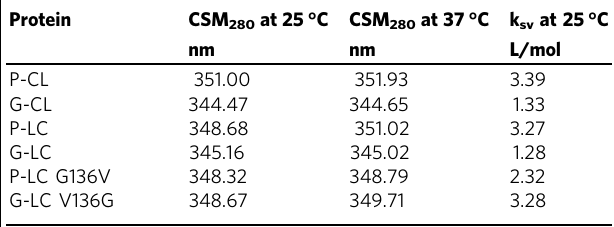
Table 2 CSM values at λ ex = 280 nm determined by REES fl uorescence spectroscopy and Stern – Volmer constants (k sv ) derived from acrylamide quenching